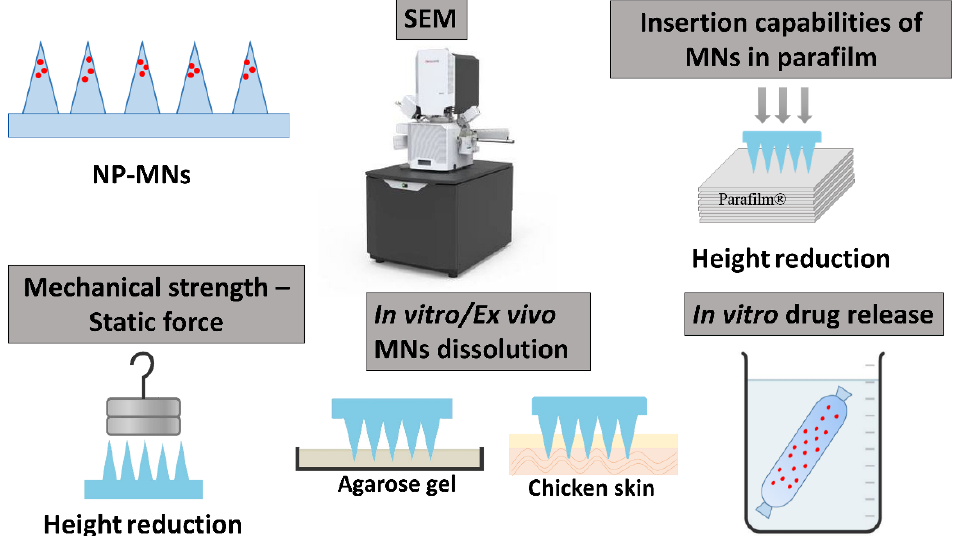
Scheme 1. Schematic representation of characterization of